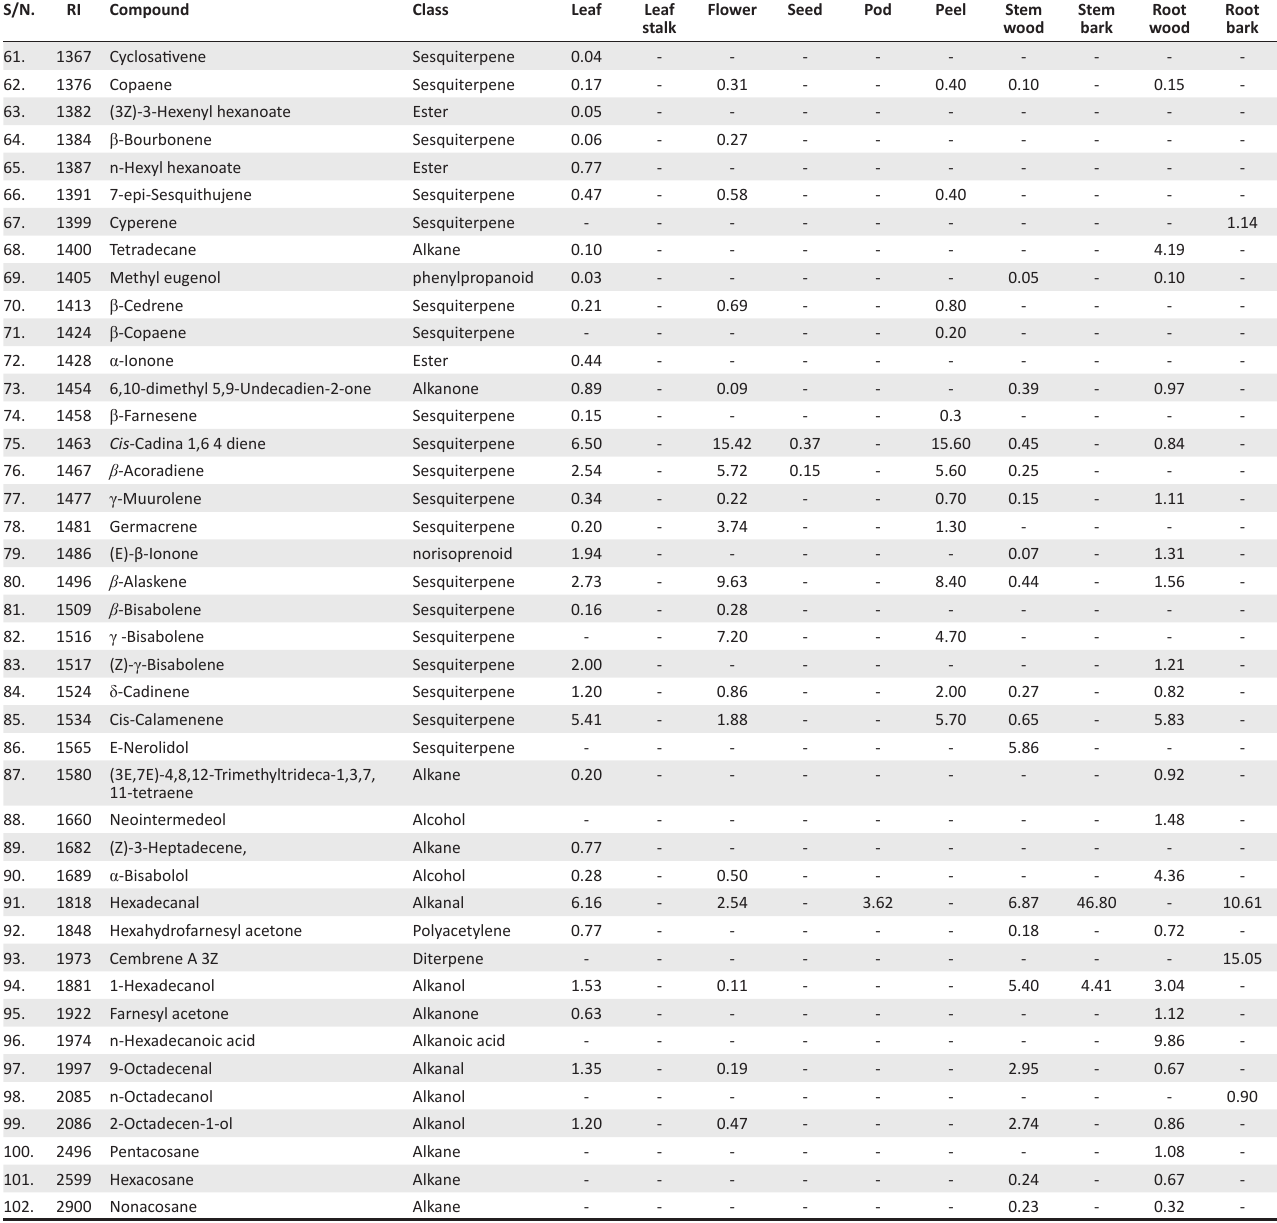
TABLE 2a(Continues...): Chemical constitution of 10 essential oils from Calophyllum inophyllum Linn. S/N.